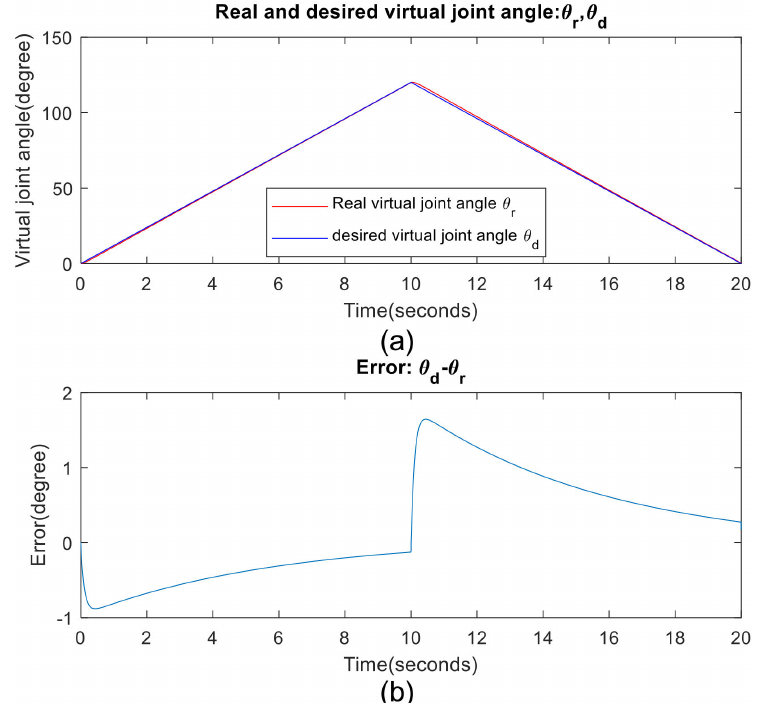
Figure 17. ( a ) Real and desired virtual joint angle; ( b ) error between real and desired virtual joint